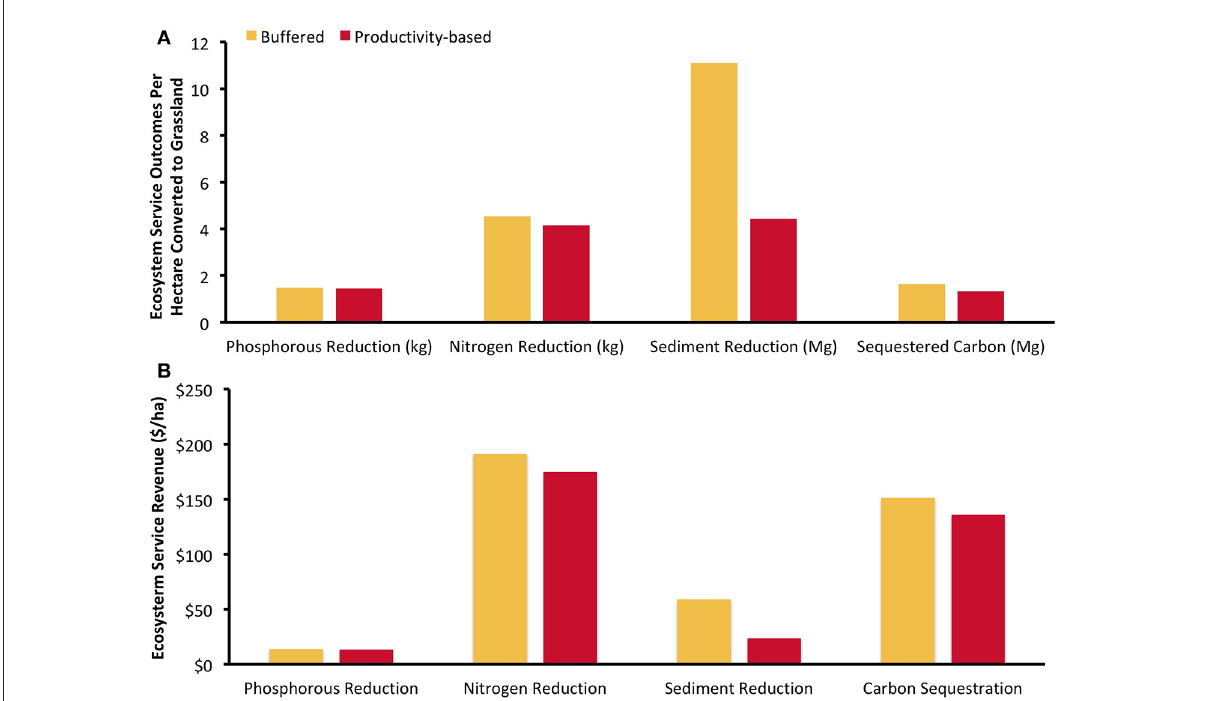
FIGURE3 Per hectare annualized ecosystem service outcomes in each alternative scenario simulated in the Grand River Basin, Iowa and Missouri, USA (A) ; phosphorus, nitrogen, and sediment values are loss reduction while the carbon value is an increase. Annualized ecosystem service related revenue also shown (B)